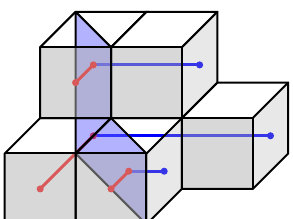
(cid:16) 2 2 1 (cid:17) . The diagonal 1 1